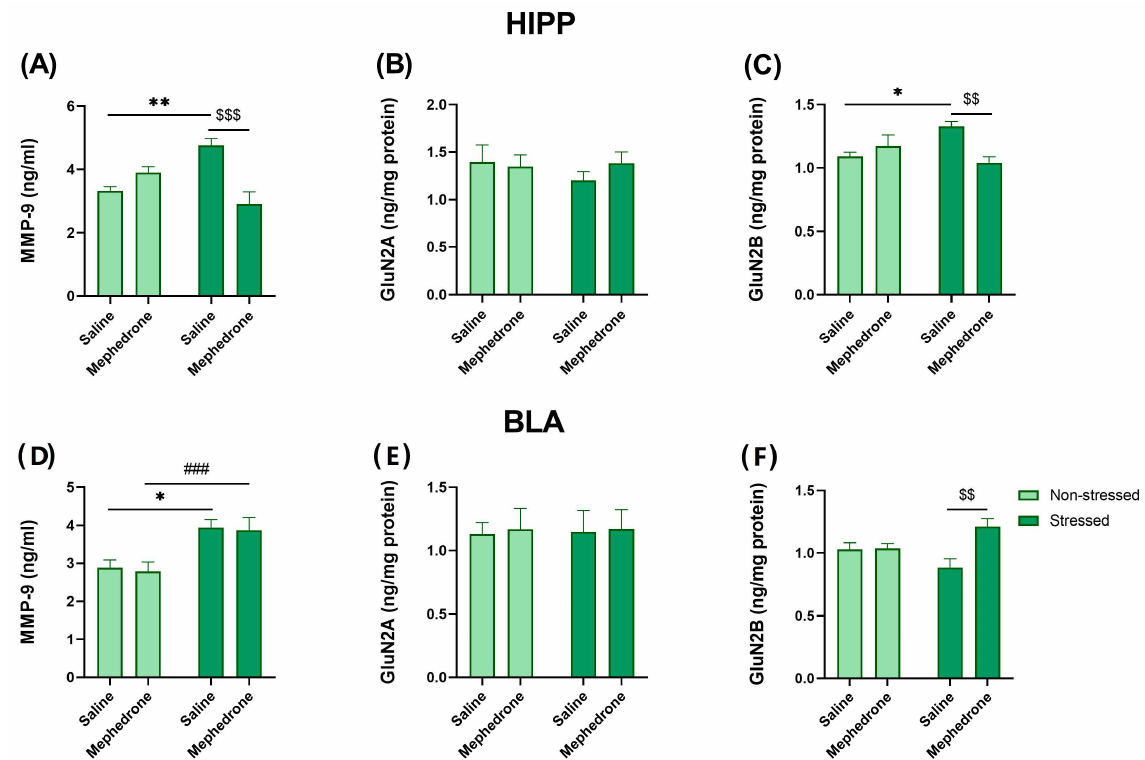
Figure 5. Impact of repeated mephedrone (5 mg/kg) injections on: the expression of ( A ) MMP-9; ( B ) GluN2A and ( C ) GluN2B in the HIPP, as well as ( D ) MMP-9; ( E ) GluN2A and ( F ) GluN2B in the BLA in the fear conditioned rats. Data represent mean ± SEM ( N = 7 rats/group). * p < 0.05 Non-stressed/Saline vs. Stressed/saline; ** p < 0.01 Non-stressed/Saline vs. Stressed/saline; ### p < 0.001 Stressed/Mephedrone vs. Non-stressed/Mephedrone; $$ p < 0.01 Stressed/Saline vs. Stressed/Mephedrone; $$$ p < 0.001 Stressed/Saline vs. Stressed/Mephedrone. Furthermore, two-way ANOVA did not show any significant effect of repeated mephedrone administration [F (1,24) = 0.2494, p > 0.05], footshock [F (1,24) =